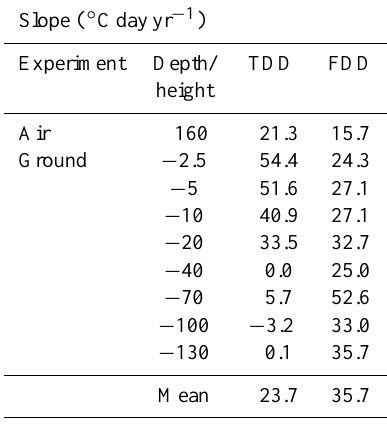
Table 6. Slope of TDD and FDD ( ◦ Cdayyr − 1 ) for the air and ground at different depths in the 2009–2012 period.